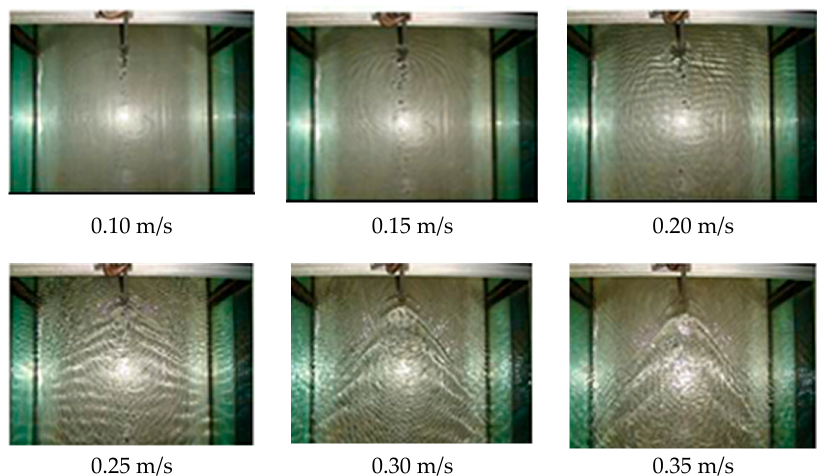
Figure 6. The wake angles versus velocity U under different penetration depths (f1r4, f1r3, f1r2 and f1r1 represent penetration depths of 1/30, 1/6, 1/2 and 1/1 of the water, respectively).